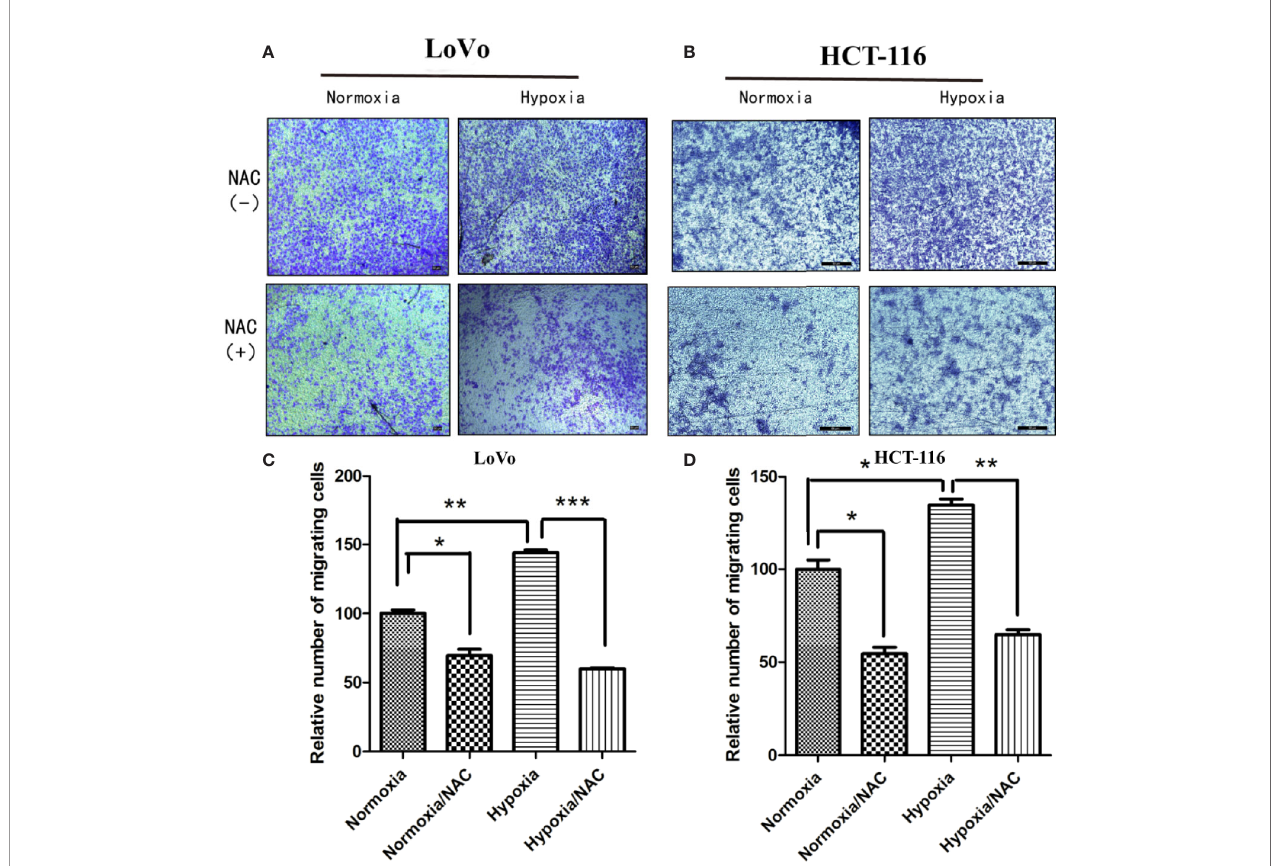
FIGURE 4 | Hypoxia accelerates migration and requires ROS generation. Transwell assay was used to evaluate the effect of hypoxia and ROS on migration ability. LoVo (A) and HCT-116 (B) cells were cultured in hypoxic condition (1% O 2 ) and treated with NAC for 24 h; cells on the lower surface of the Transwell membrane were stained with 0.1% crystal violet; the number of migrated cells was photographed under 50× magni fi cation; Data are expressed as mean ± SD, n=3 (C, D) . (* P < 0.05, ** P < 0.01, *** P <